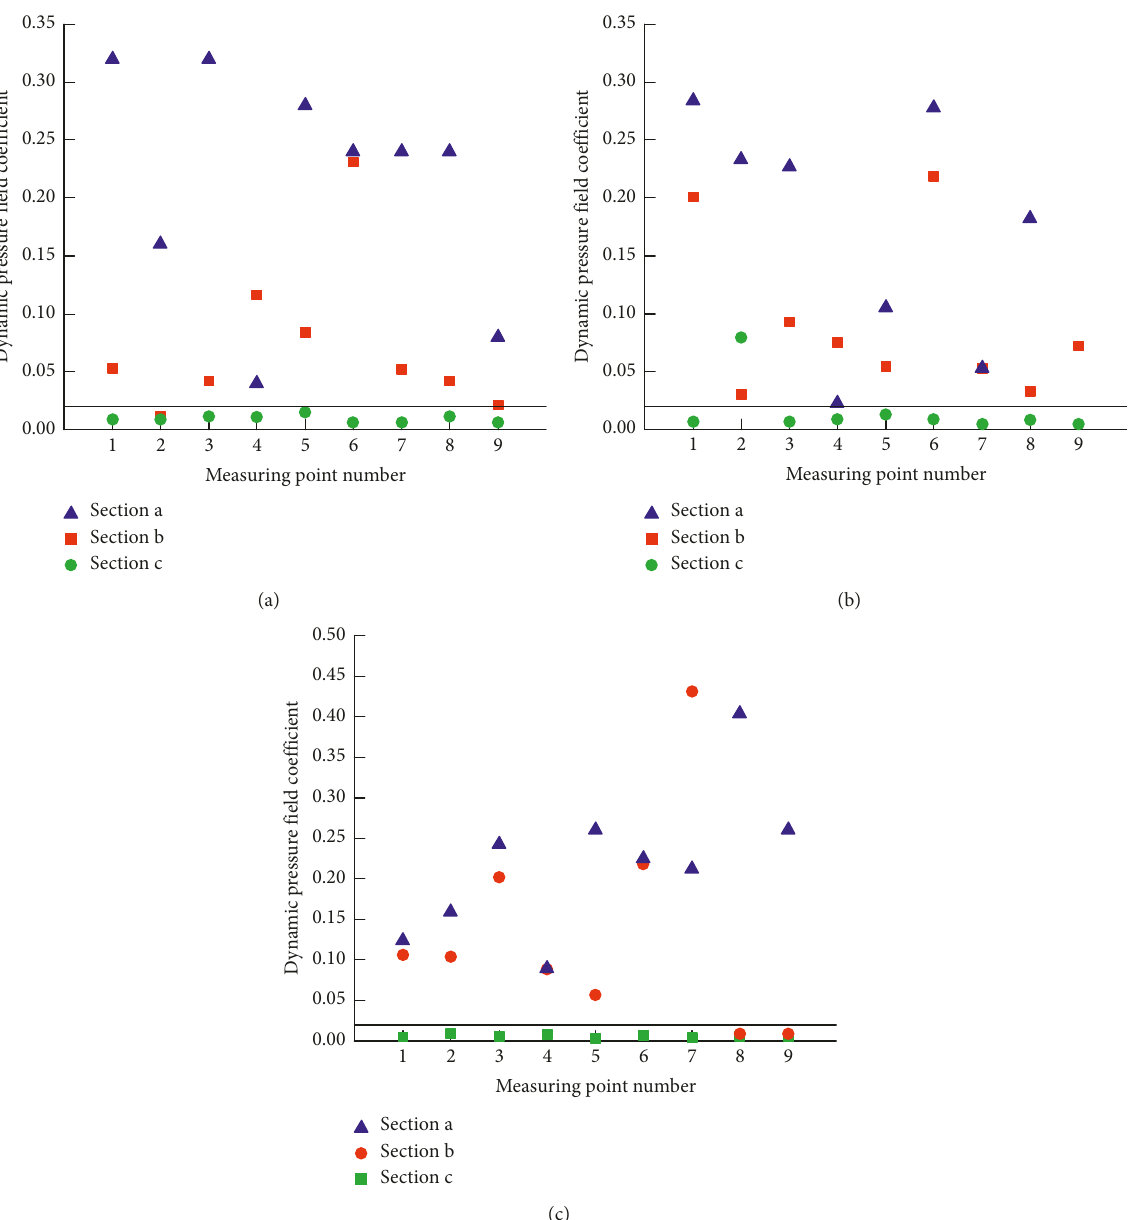
Figure 4: Dynamic pressure field coefficient under different frequencies: (a) 30 Hz, (b) 40 Hz, and (c) 50Hz. Table 1: Deviation mean squares of wind speed and average speed. Fan frequency